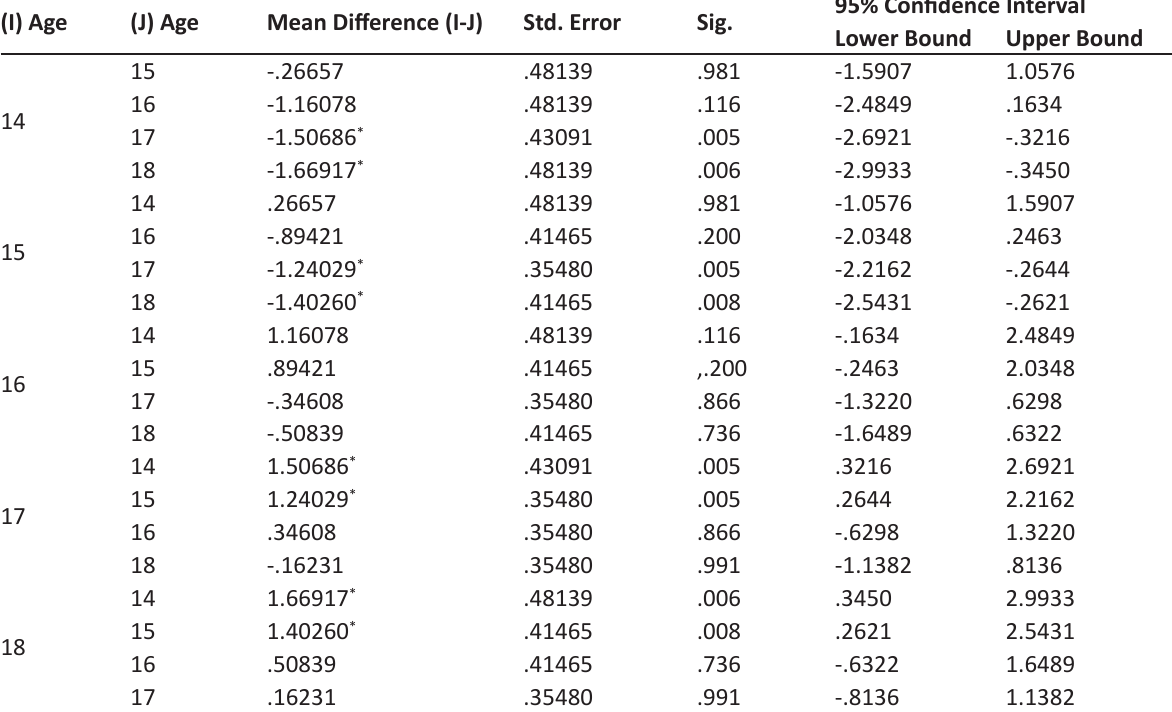
Table 4. Body mass index in male subjects depending on age – multiple comparisons a with Tukey